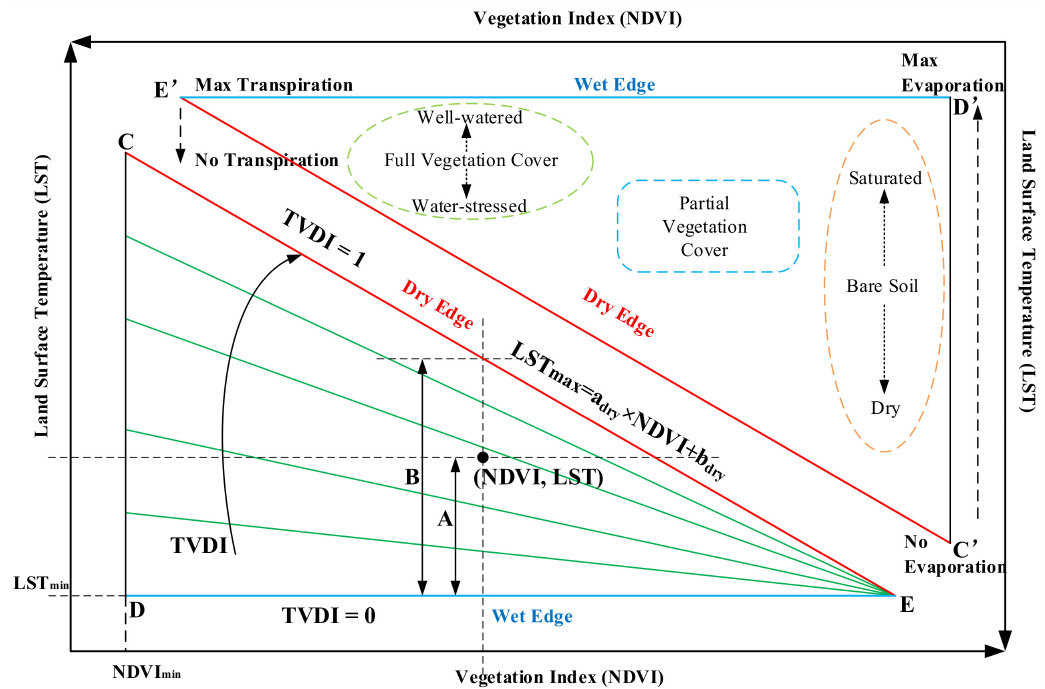
Figure 2. Conceptual diagram of the NDV-LST triangle space (TVDI) for determining soil moisture (adapted from [29,73,74]). Soil moisture is minimal along the dry edge and maximal along the wet edge. Soil moisture in a given pixel is linearly interpolated as the proportion between dry edge CE in red color and wet edge DE in blue color (see Equation